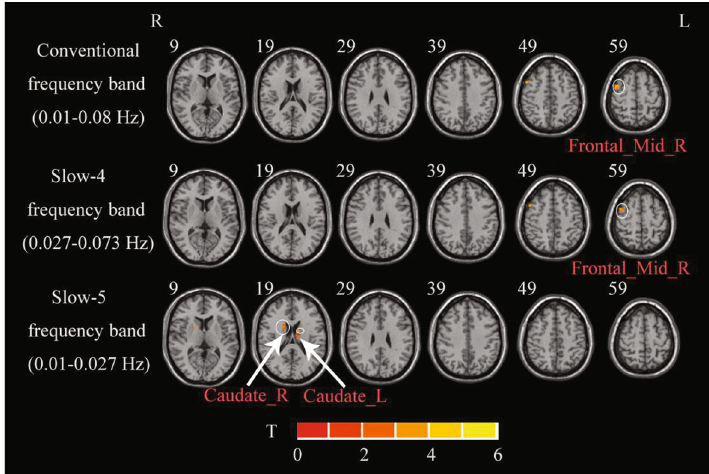
Figure 3: A two-sample t -test was performed between acute BGIS patients and HCs. R: right hemisphere; L: left hemisphere; BGIS: basal ganglia ischemic stroke; HCs: healthy controls; fALFF: fractional amplitude of low frequency fl uctuation. Table 3: The correlation results between brain regions and clinical measures.